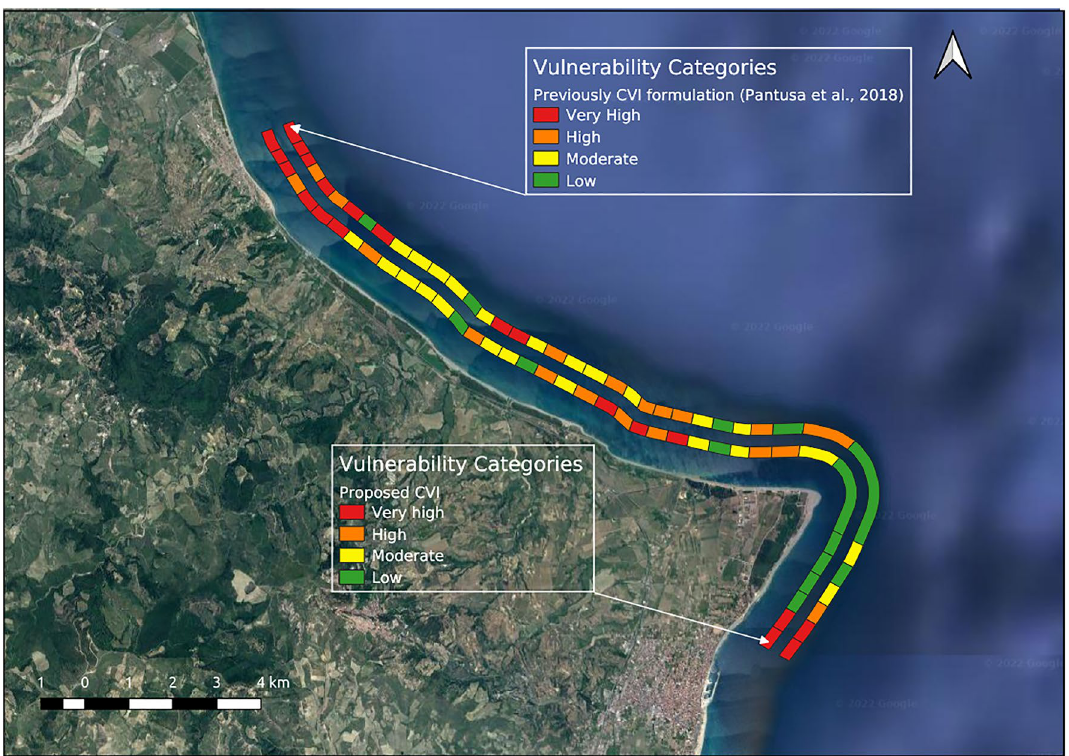
Figure 6. Proposed CVI formulation and previously CVI formulation 27 . The map was created using QGIS 3.29 software (https:// qgis.